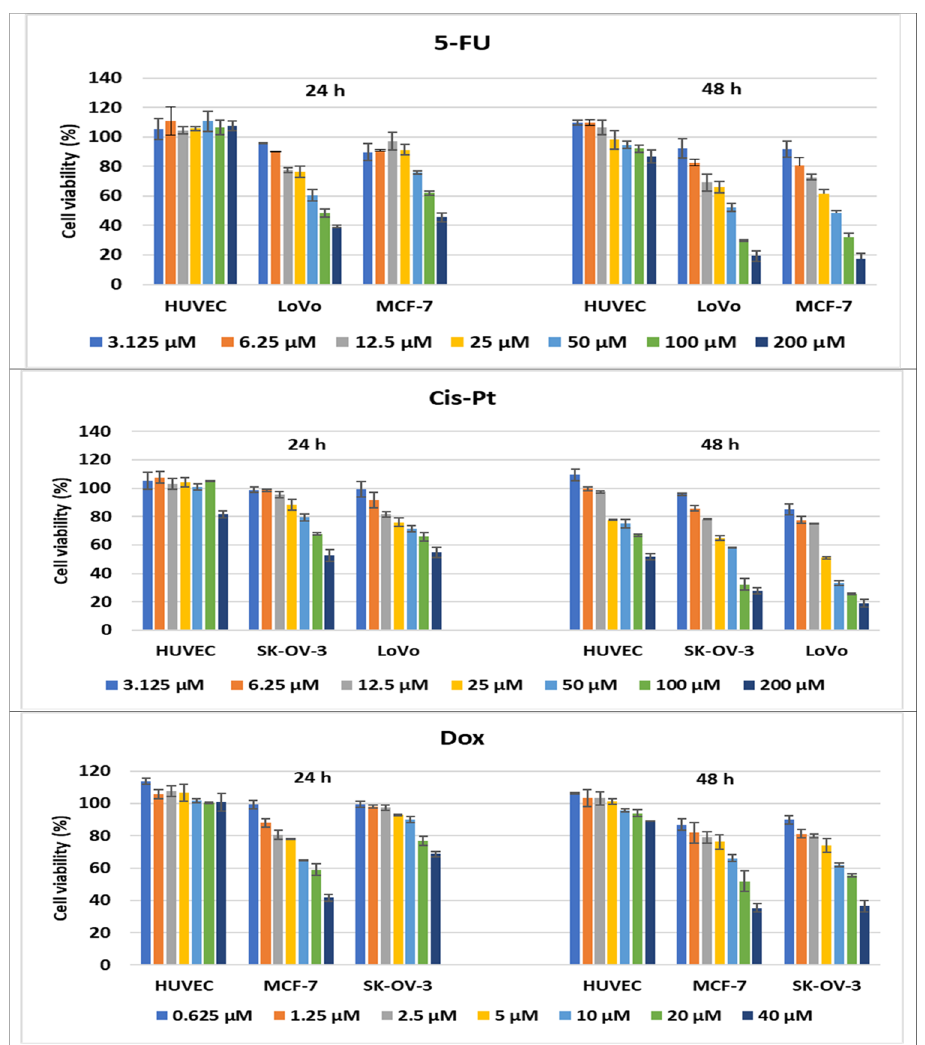
Figure 14. Antitumor effect of oncolitical control drugs against cancer vs. normal cell lines. The cell viability was measured after cell treatments with scalar concentrations of drugs for 24 or 48 h and compared to that of untreated control cells. Data are expressed as the mean values ± standard deviations (SDs) of three different experiments ( n = 3).